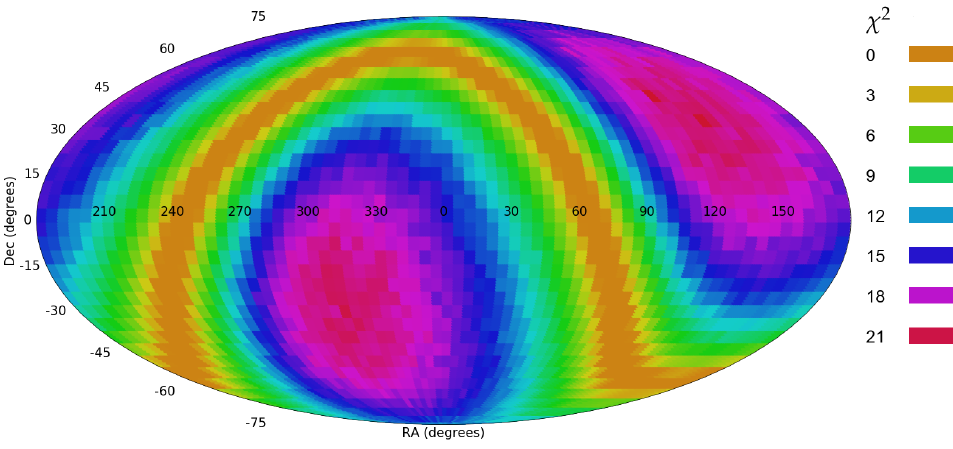
Figure 19. The χ 2 probability of a dipole axis such that the galaxies are assigned with random spin directions, except for two sky regions that do not necessarily form a